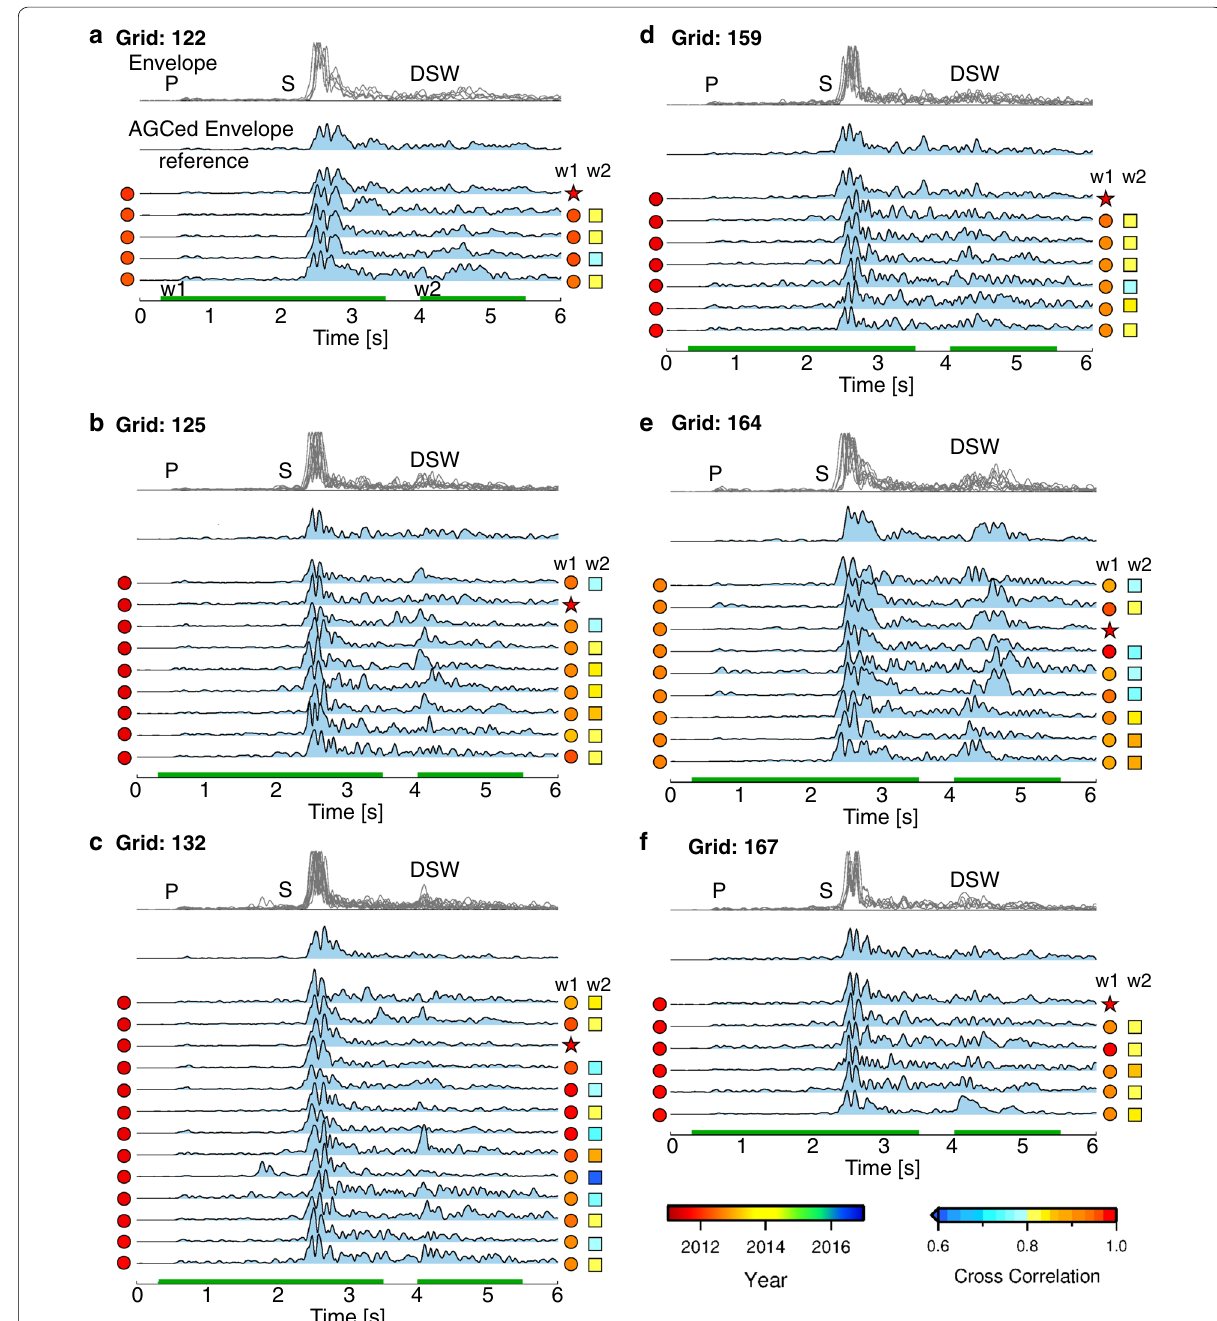
Fig. 4 N–S component band-pass filtered (8–24 Hz) envelopes for events with similar waveform of direct waves at hypocenter grid numbers of a 122, b 125, c 132, d 159, e 164, and f 167. Gray lines on the top in each panel show the overwriting of envelopes. Colored envelopes were modified by applying auto gain control to improve the visibility of the DSW. Color of circles on the left-hand side of envelopes shows the year of event occurrence. Color of circles and squares on the right-hand side of envelopes represents the cross-correlation for direct wave and DSW to the reference event marked by a star. Green lines on the time axis indicate the time window of CC calculations. All traces are aligned with P-wave